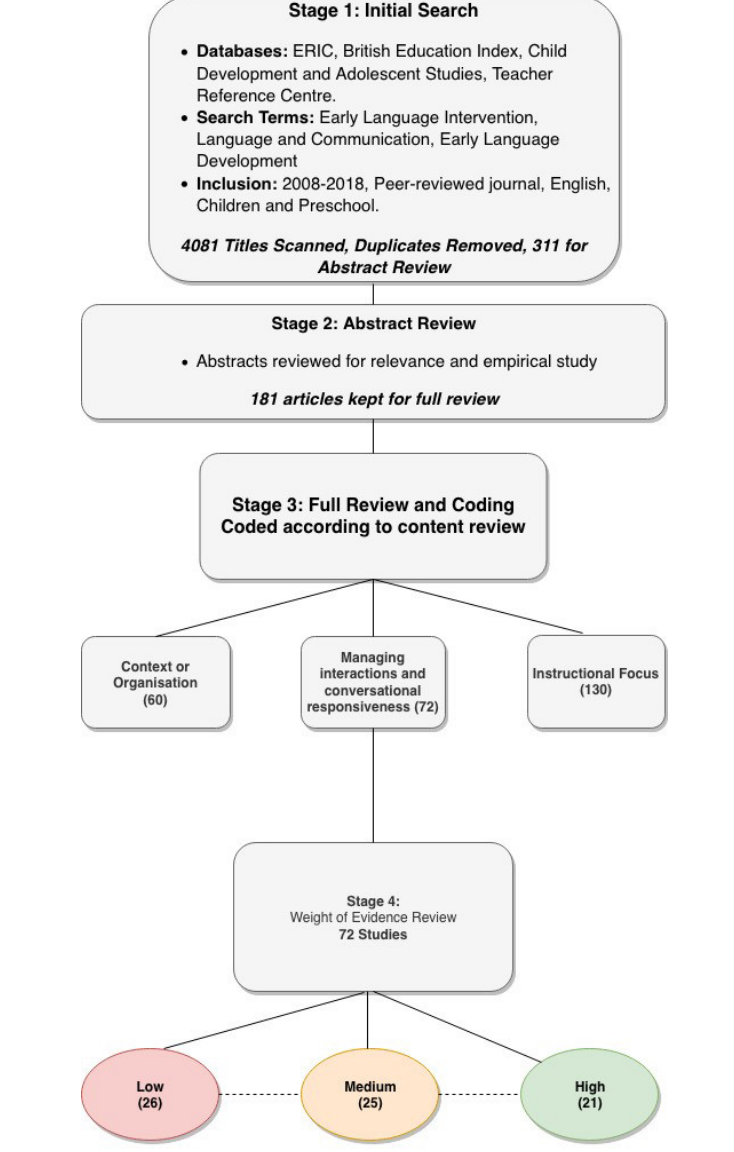
Figure 1. Review flow diagram (Source: